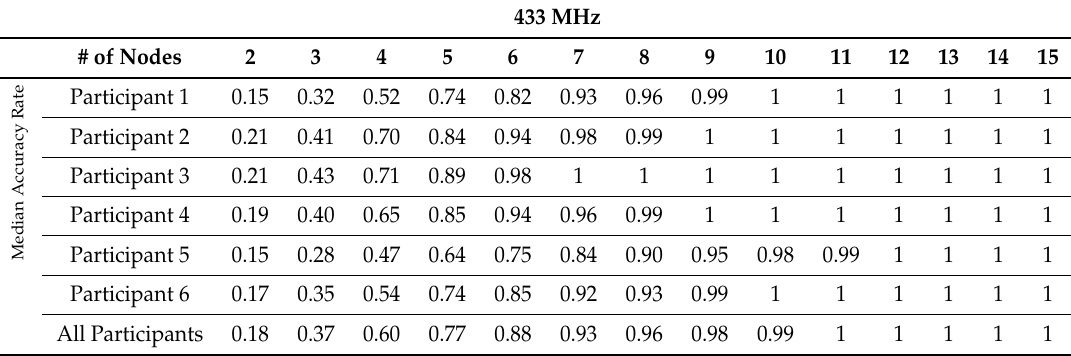
Table 3. Median accuracy rates obtained by using a naive Bayesian classifier on data from the 433 MHz network.